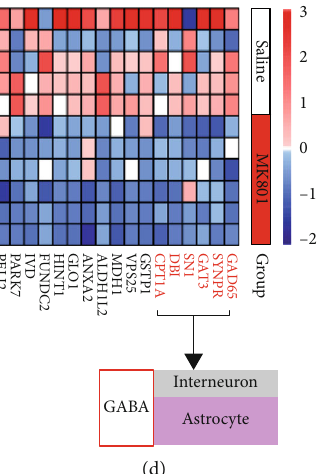
Figure 4: Integrative analysis of proteomics and single-cell sequencing data of di ff erentially expressed proteins in adolescent mice. (a) All of the di ff erentially expressed proteins in PFC identi fi ed in proteomics analysis were mapped to the mouse brain single-cell sequencing database (http://mousebrain.org). We downloaded the expression value of each di ff erentially expressed protein within its clustered cell types in the cortex. A total of 45 cellular subtypes were showed, consisted of fi ve major cell types of excitatory neurons, inhibitory neurons, astrocytes, oligodendrocytes, and microglia. Hierarchical clustering of the expression of signi fi cant proteins in all cell types showed their prominent cellular location. Red: higher protein expression. Blue: lower protein expression. Protein ’ s expression was scaled in a row and represented as Z score. Pie graphs on the right panel showed the number and percentage of downregulated proteins in each cell type. (b, c) Top GO enrichment of biological function of di ff erentially expressed proteins in interneurons and astrocytes. Circle size represents the protein numbers in each item. (d) Heatmap of di ff erentially expressed proteins involved in the metabolic processes in astrocytes and interneurons. Proteins associated with GABA signaling were from astrocytes and interneurons and downregulated after postnatal MK-801 injection. Each square represents one sample. Red: upregulated. Blue: downregulated. Protein ’ s expression was scaled in a row and represented as Z